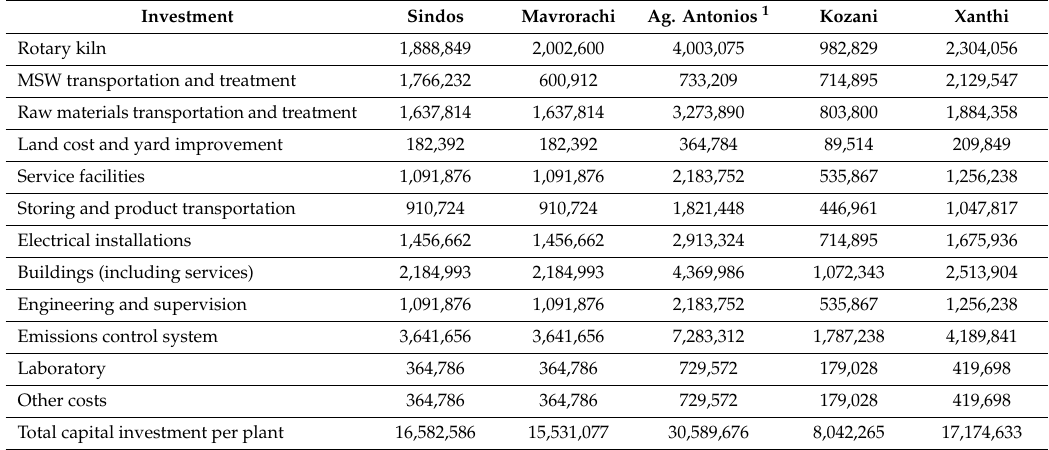
Table 7. Analysis of investment costs in ( € ) for ZWMP